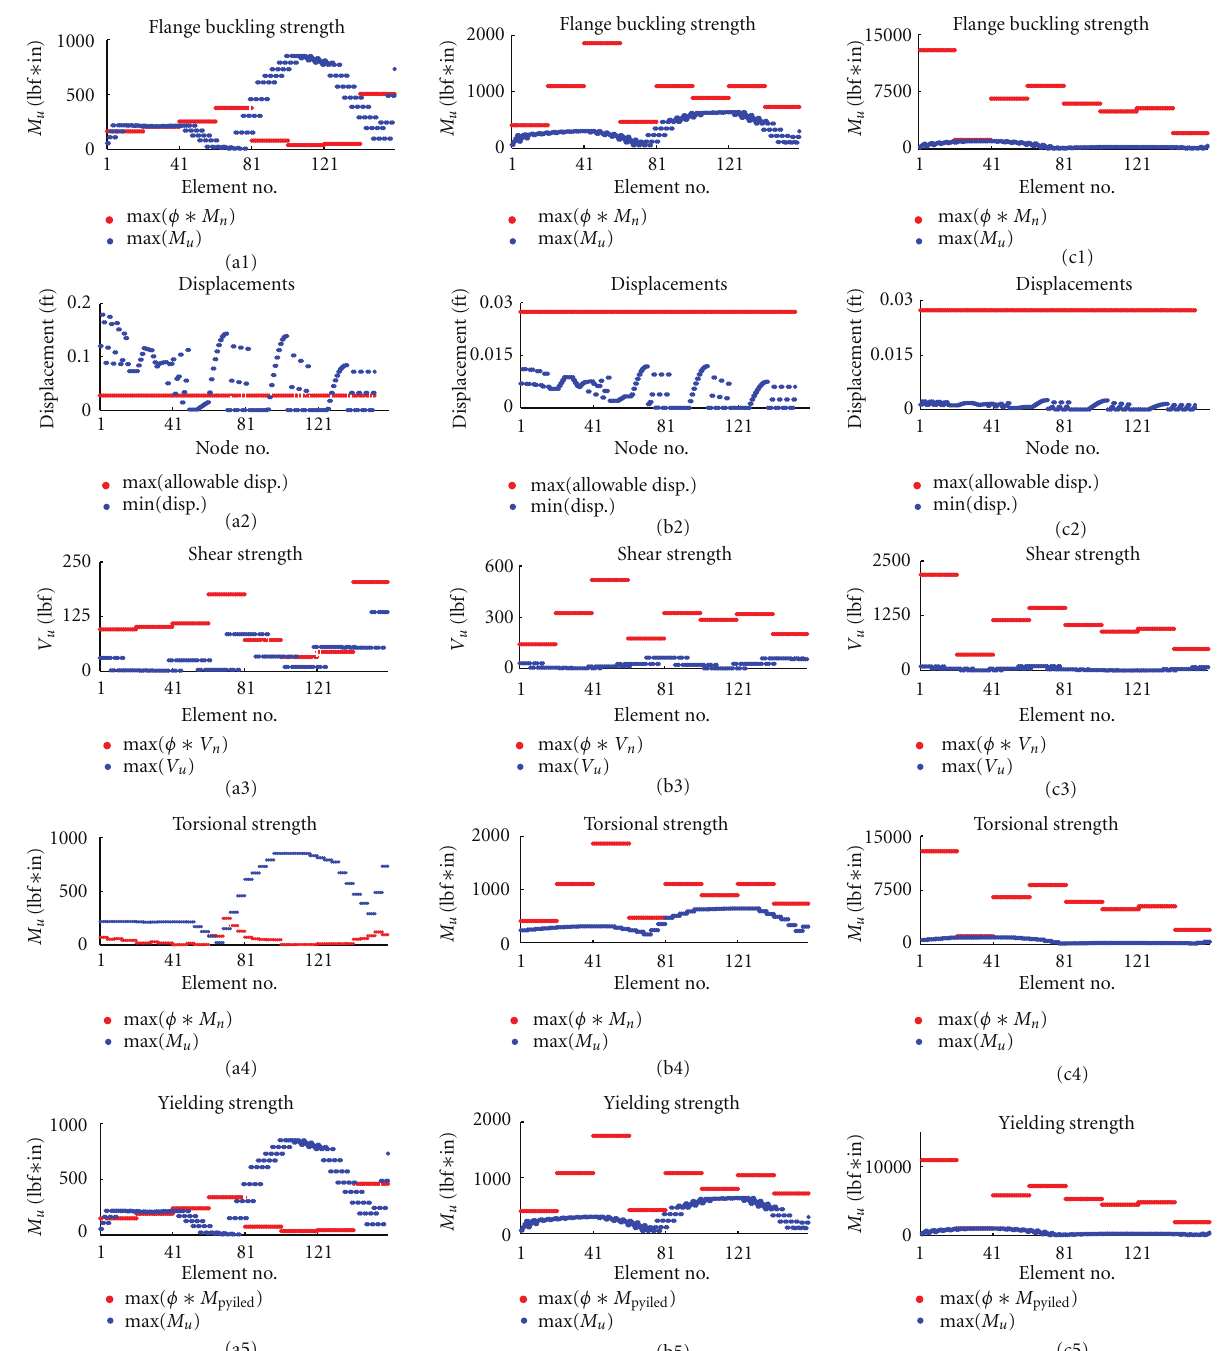
Figure 10: Strengths and displacements of random penalized solutions corresponding to minimum displacement (a1)–(a5), unpenalized solutions corresponding to maximum displacement (b1)–(b5), and maximum weight (c1)–(c5) (see Figure 9).